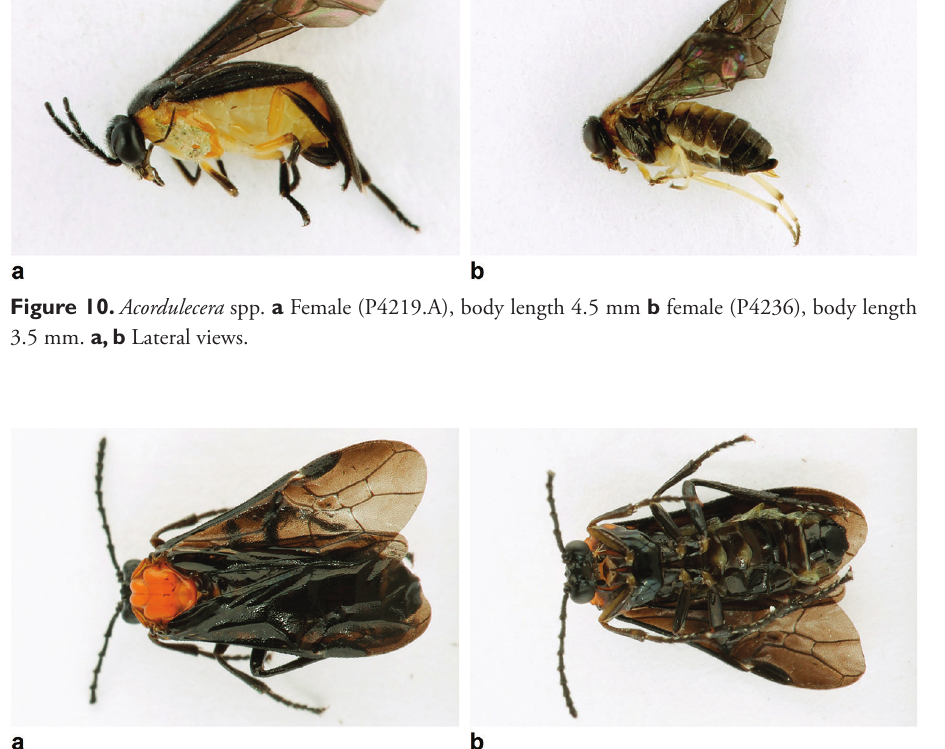
Family Tenthredinidae Subfamily Blennocampinae Waldheimia pallens (Klug, 1816) Fig. 12 Material. Estación científica Yasuní, near río Tiputini, 00°40'S, 076°24'W, 220m, 02.03.2015, P4119.A (1 ♂ ), leg. T. Delsinne; Estación científica Yasuní, 00°36'S, 076°30'W, 240m, 14.11.2016, by sweeping, P4215.H (1 ♀ ), P4215.J (1 ♂ ), leg. A. Pauly, J.-L.